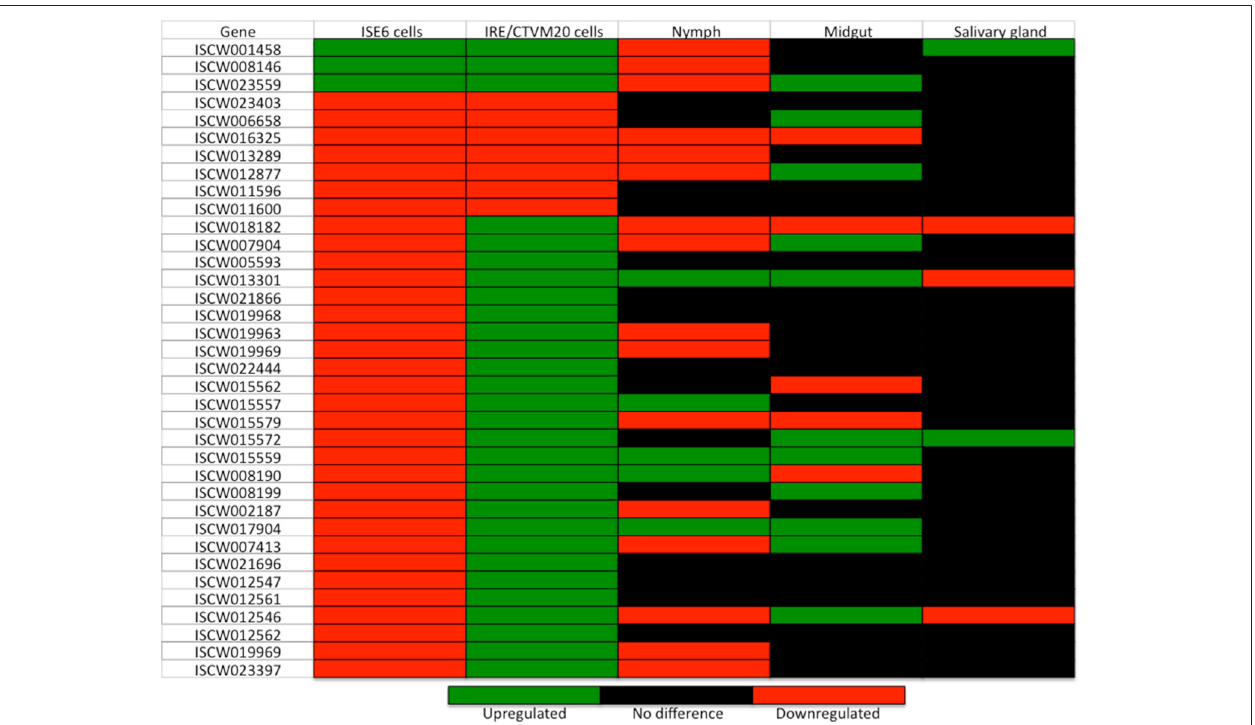
FIGURE 6 | Transcriptional profile of genes differentially expressed in both A. phagocytophilum -infected I. ricinus IRE/CTVM20 and I. scapularis ISE6 cells and in comparison with infected tick samples. Differential expression ( p ≤ 0.05 ; q ≤ 0.05 ) is shown for I. scapularis ISE6 cells, I. ricinus IRE/CTVM20 cells, and I. scapularis nymphs and adult midguts and salivary glands. Data for tick samples was obtained from Ayllón et al.